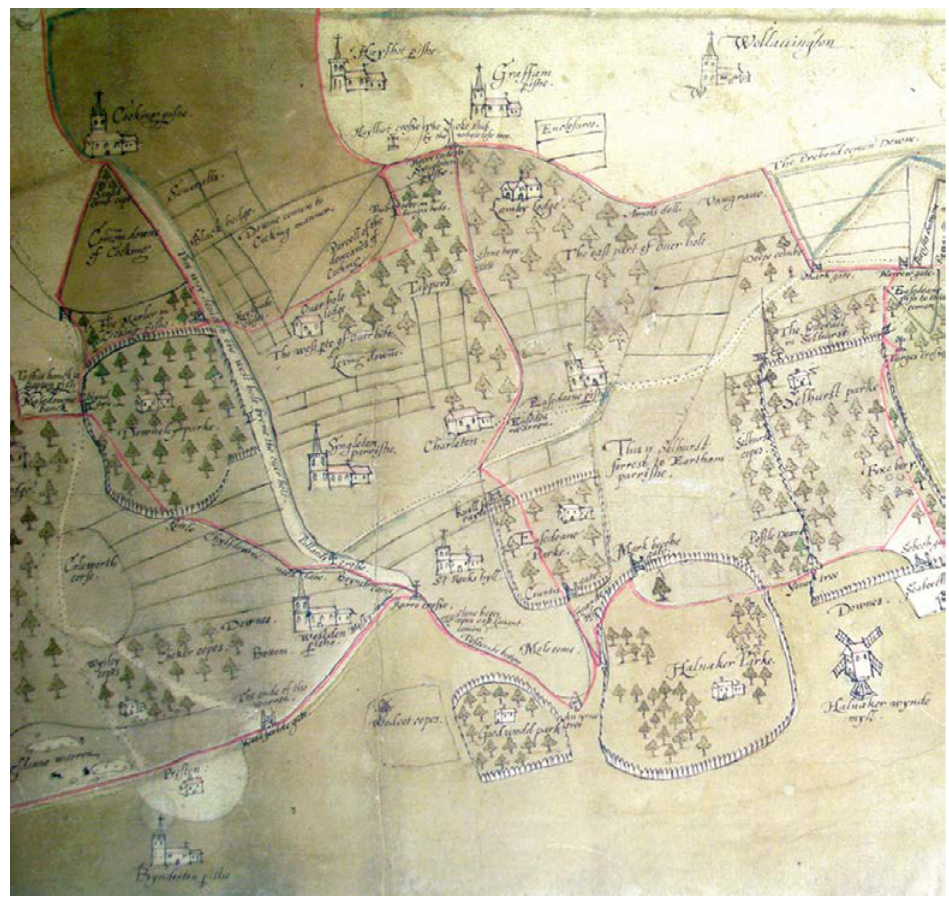
Fig. 5: Arundel Archive Map ( PM 193). The park at Downley can be seen on the left of the image adjacent to the Chichester to Midhurst road. (From the Arundel Castle Archives, reproduced by kind permission of His Grace the Duke of